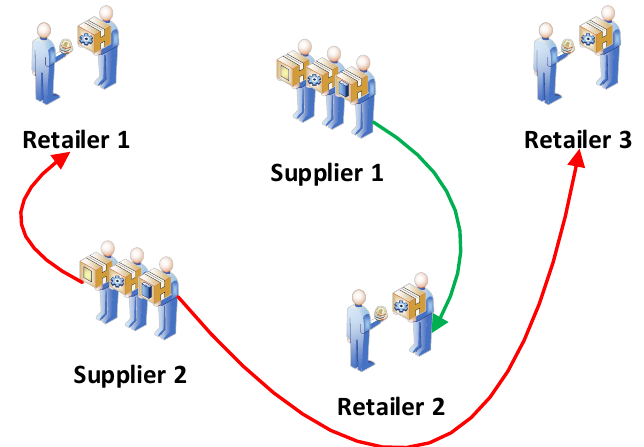
Figure 3. Optimized vehicle route for order delivery .